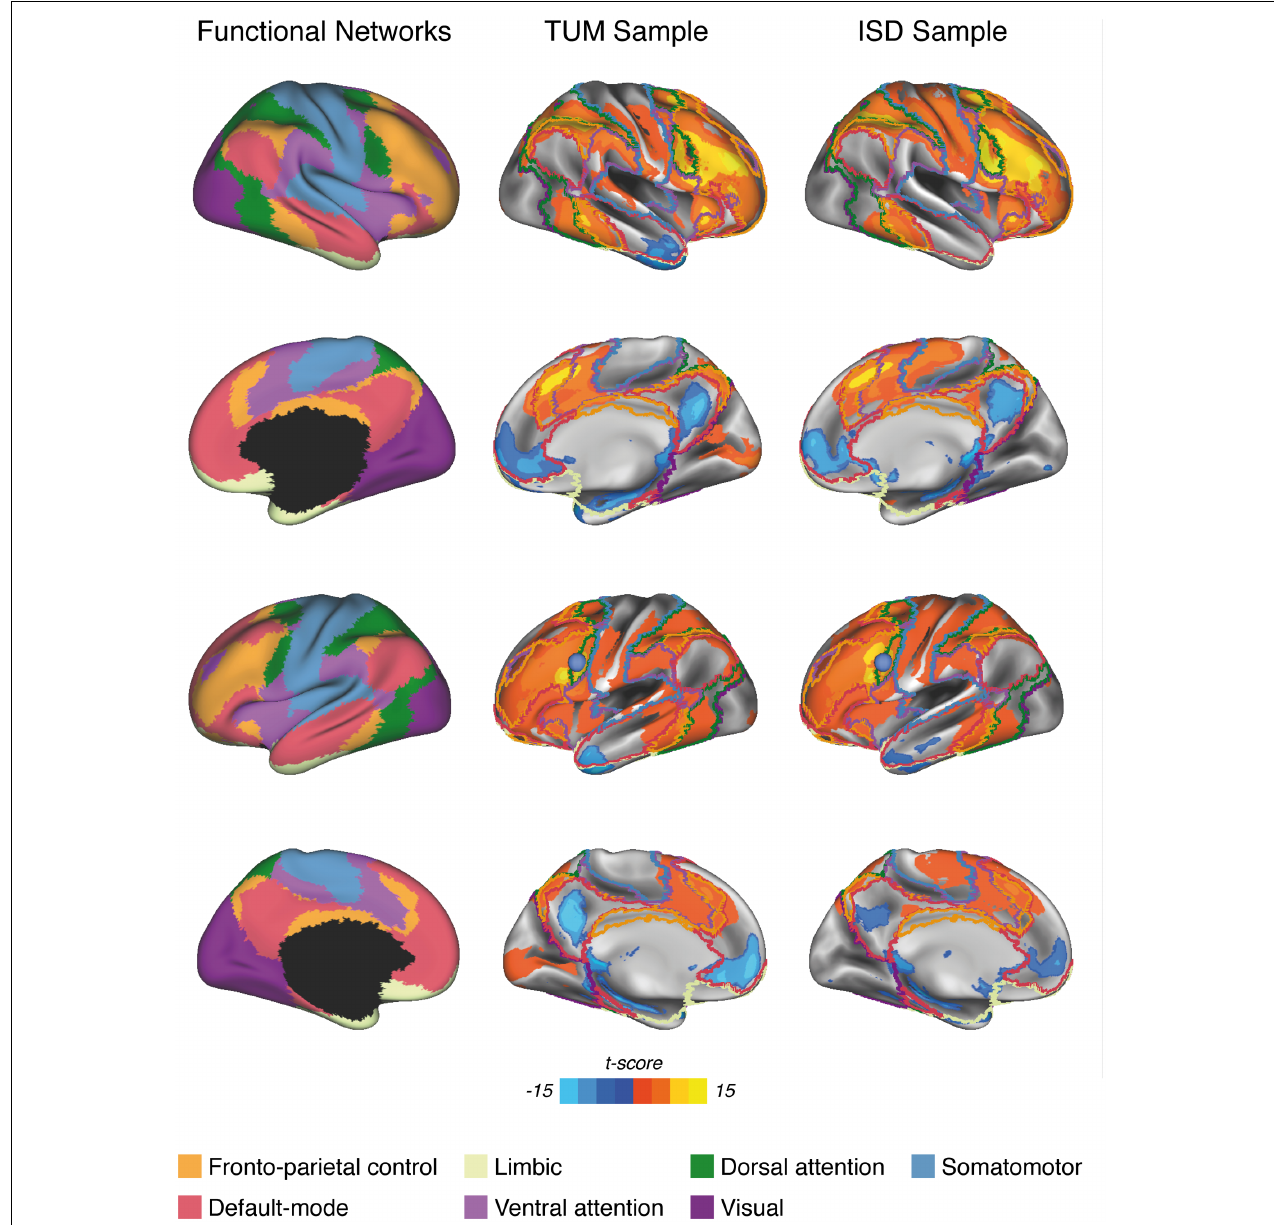
FIGURE 1 | Surface renderings of significant LFC-connectivity in the TUM sample and the ISD sample (pooled across diagnostic groups) at a voxel threshold of α < 0.001, FWE-cluster-corrected at α < 0.05, superimposed on the functional network parcellation that was used for the current analyses. The LFC seed-ROI is superimposed as a blue sphere on surface renderings of the left hemisphere (3 rd